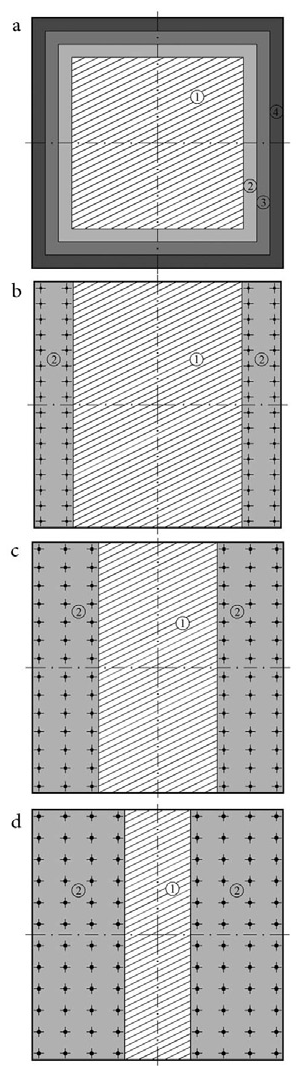
fig. 4. Distribution of deformable soil bed values: a – unpiled plate; b – 2 and 2 rows; c – 3 and 3 rows; d – 4 and 4